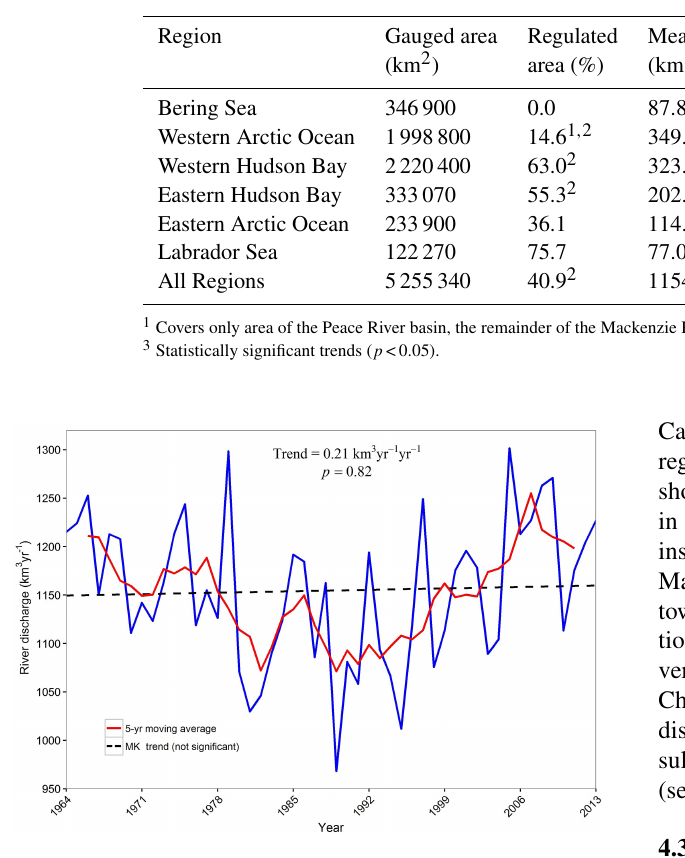
Figure 3. Time series of total annual discharge for 42 rivers draining northern Canada,